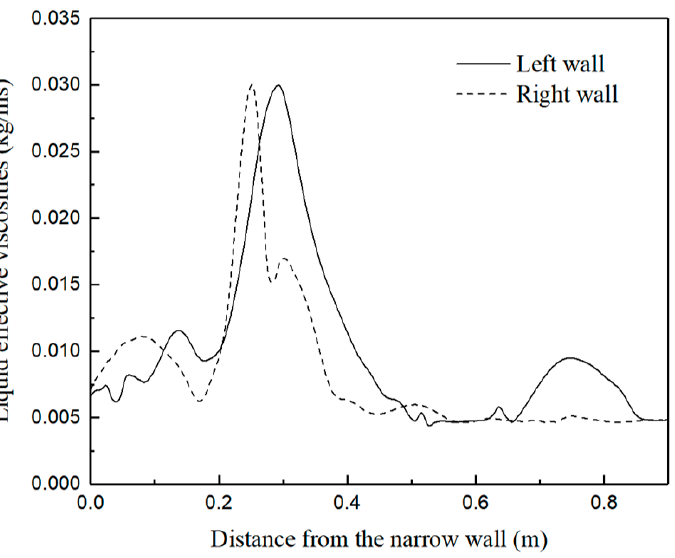
Figure 18. Effective viscosity of the turbulent flow along the centerline at both sides of the mold at the transformation stage.